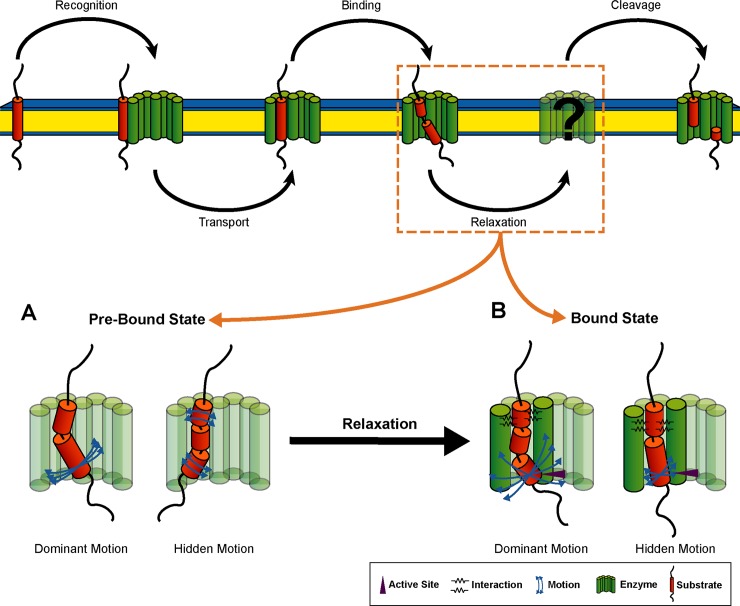
Binding-induced reorganization of C99 TMD conformational dynamics.(A) In the pre-bound state, large-scale bending coordinated by the G37G38 hinge prevails over low-amplitude motions where the helix flanks bend correlated with respect to the middle domain around hinge sites at V36G37 in TM-N and T43V44 in TM-C. Blue arrows indicate variability between backbone motions of WT and FADs. (B) Binding interactions (black springs) can selectively enhance this double-hinge motion, thus linking the region upstream to the ε-sites to catalytically important conformational relaxations. Consequently, softening or shifting the hinges in FAD mutants might affect the way in which the ε-cleavage sites interact with the enzyme's active site (purple arrow).